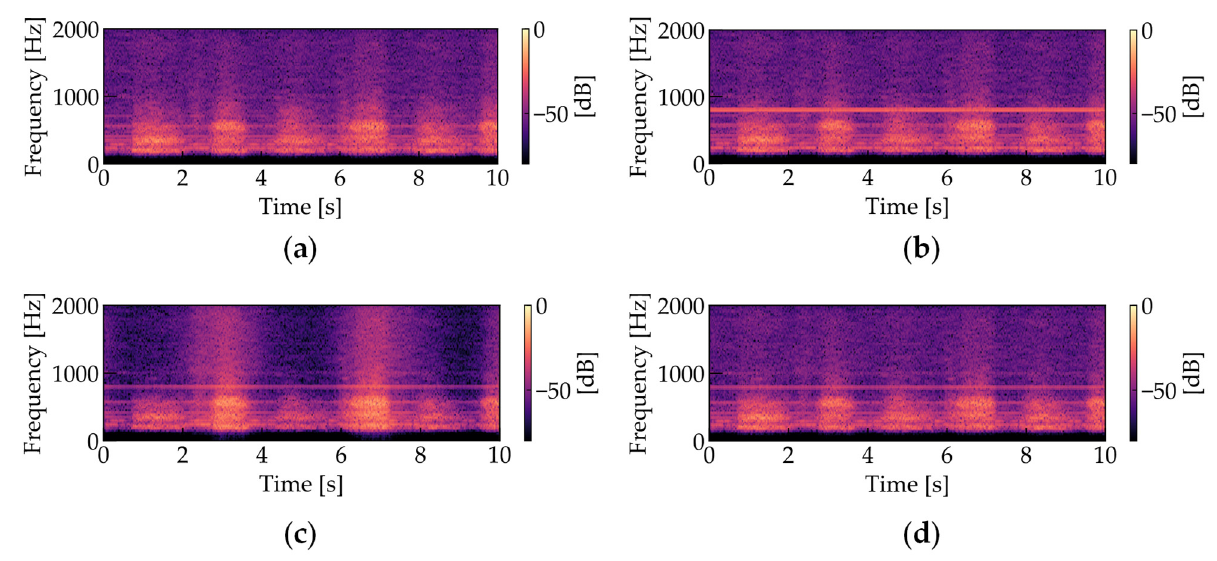
Figure 7. Amplitude spectrograms of respiratory sounds (The parameters were set as follows: sampling frequency = 44.1 kHz, window length in STFT = 1024 points, window length in STFT = 512 points): ( a ) noiseless; ( b ) noise-added; ( c ) processed with SCNMF ( R = 30, J = 15, K = 10, i CNMF = 200, i SCNMF = 200, β = 2); ( d ) processed with the proposed OCNMF ( R = 30, J = 15, K = 10, i CNMF = 200, i OCNMF = 200, β = 2, µ = 1.0 × 10 6 ).